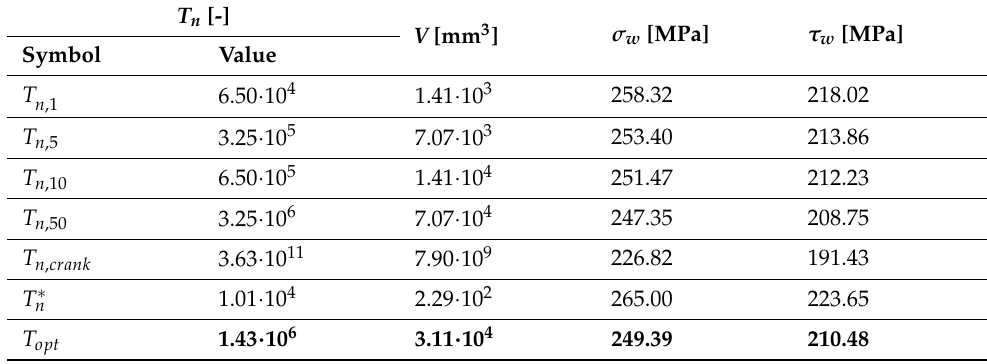
Table 4. Return period, prediction volume and fatigue limits for EN-GJS-600-3 DCI.